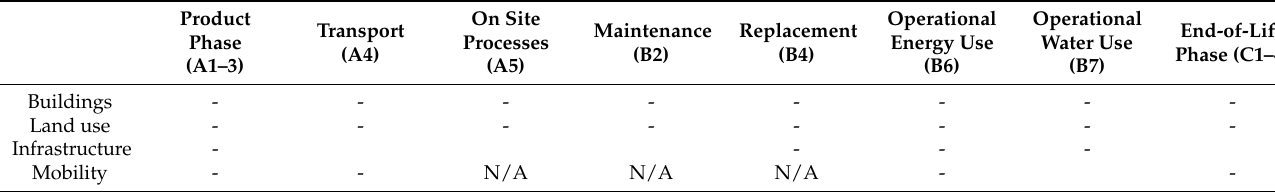
Table 2. Building life cycle stages defined by NEST.